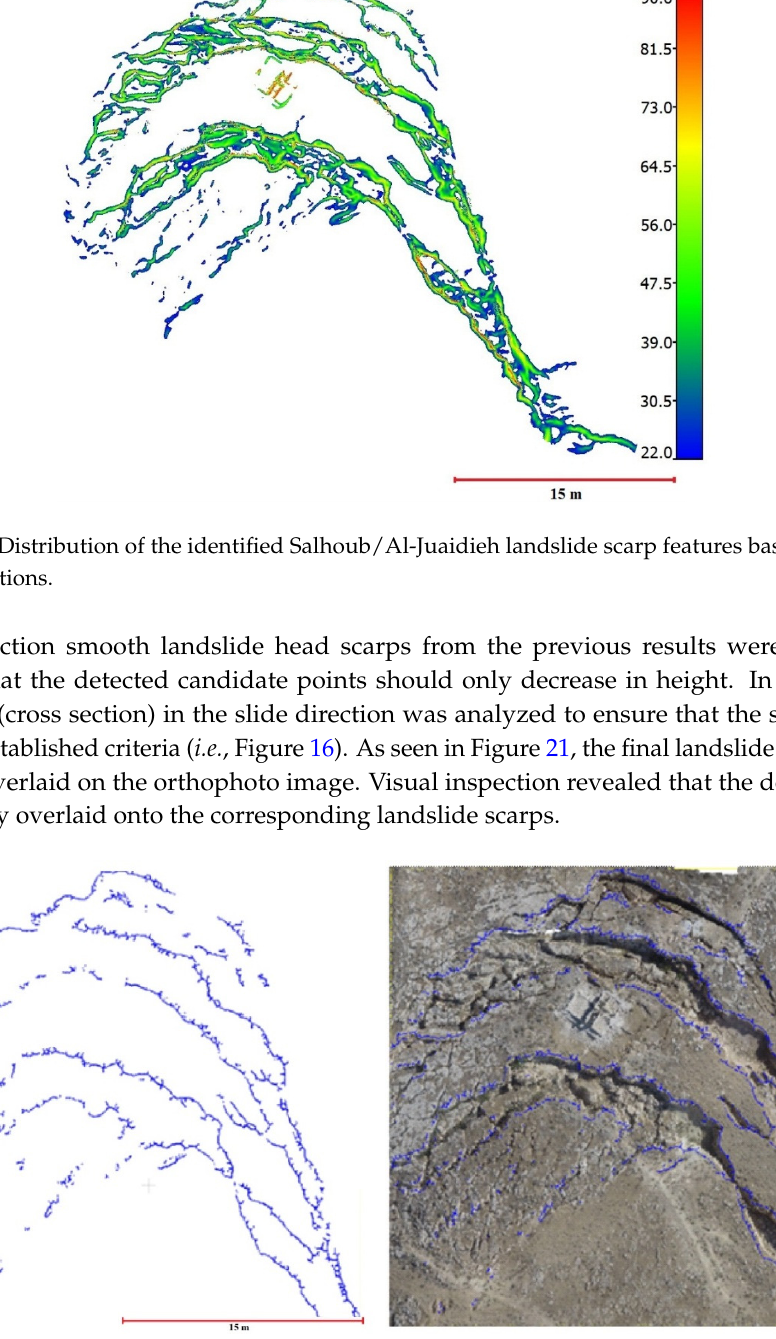
Figure 21. Final landslide scarp detection results (blue) overlaid on the orthophoto generated used UAV images of the study area. UAV images of the study